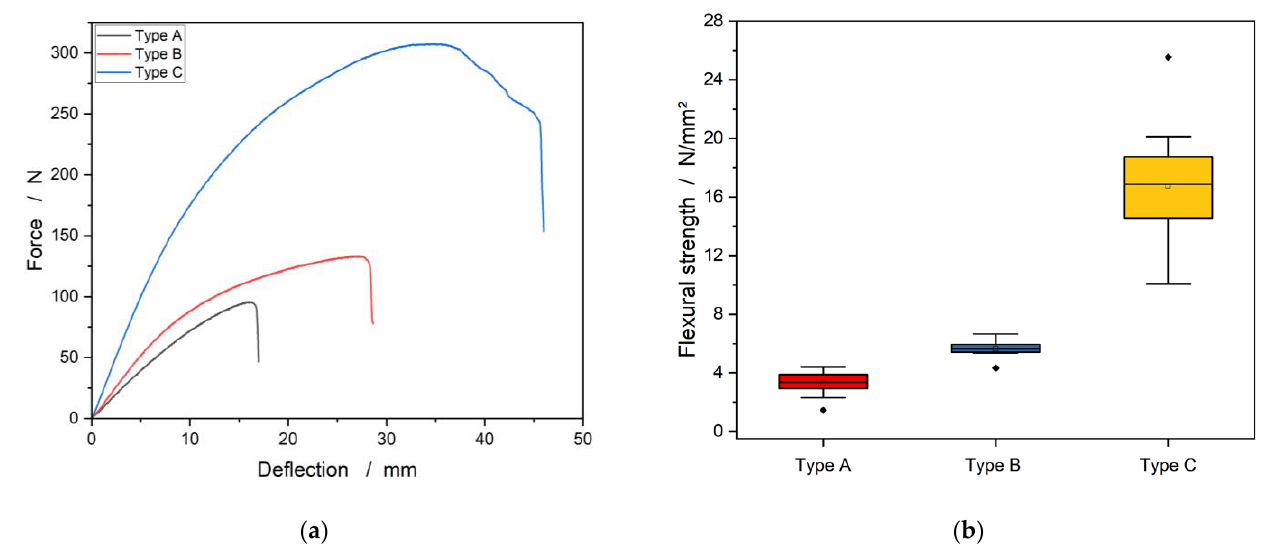
Figure 4. The influence of the FAR to: ( a ) load – deflection curves and ( b ) to the flexural strength of the Luffa sandwich panels.